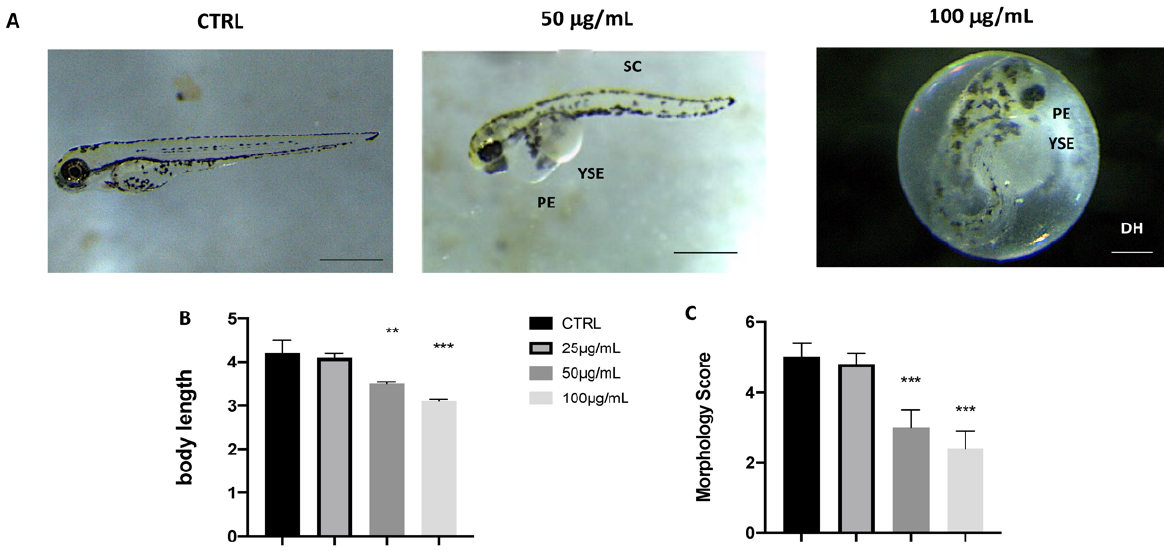
Figure 2. Effects of fotemustine on morphological changes in zebrafish larvae at 72 hpf. Representative lateral views ( A ), body length ( B ), and morphological scoring( C ) of zebrafish larvae treated with fotemustine 50 µg/mL. *** p < 0.001 versus CTRL; ** p < 0.01 versus CTRL. PE—pericardial edema; YSE—yolk sac edema; SC—scoliosis; DH—delayed hatching. Scale bars 40x magnification.